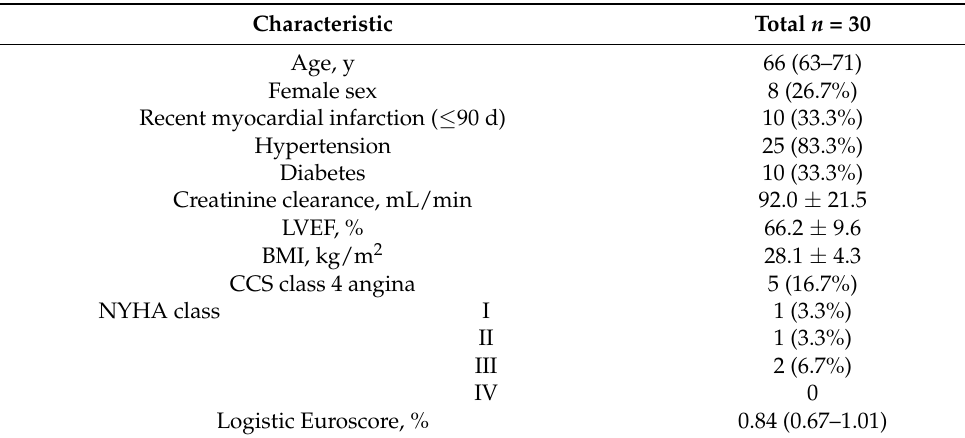
Table 1. Demographic and clinical characteristics of study participants.